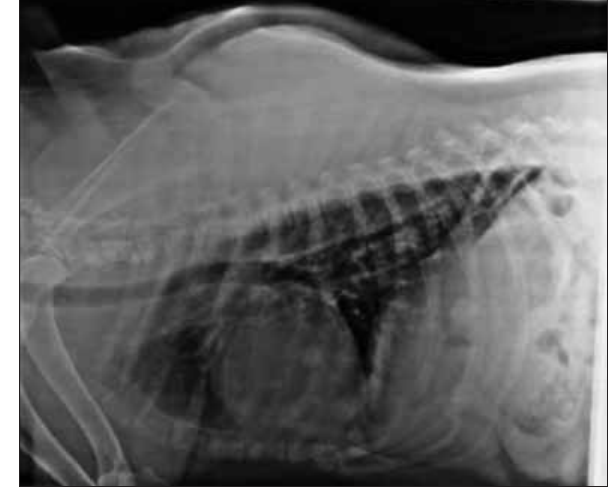
Figure-9: Lateral view radiograph of animal affected with both DCM and PE.